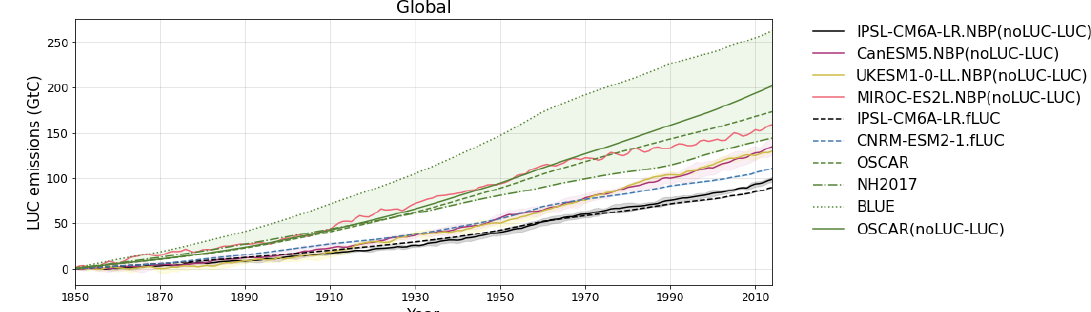
Figure 2. Evaluation of cumulative global LUC emissions by ESMs against three bookkeeping models. LUC emissions are defined by two methods: (1) the difference in NBP between simulations with and without LUC (solid lines) and (2) the “fLuc” variable provided in CMIP6 (dashed lines). The estimates of the bookkeeping approach using OSCAR are shown for cases with (noLUC-LUC) and without LASC. The range of bookkeeping models is shaded